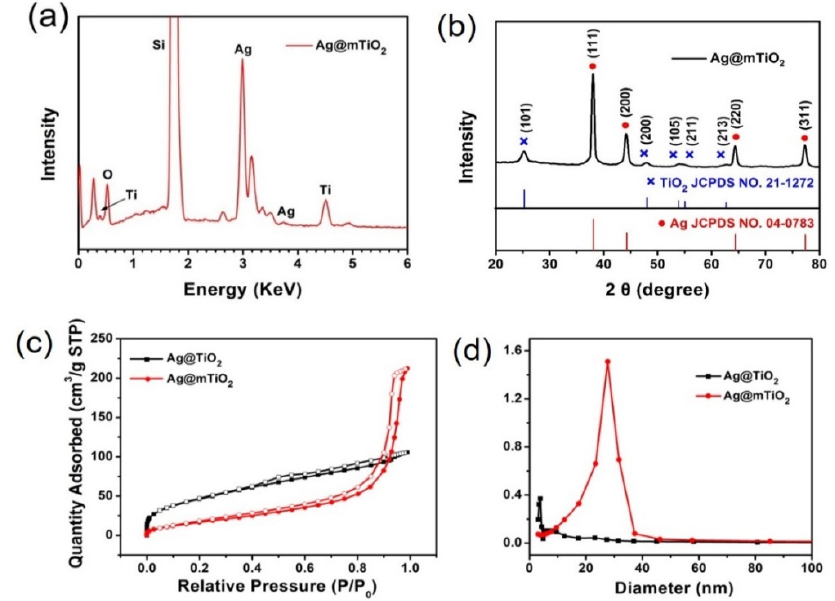
Figure 2. ( a ) EDX spectrum and ( b ) XRD pattern of Ag@mTiO 2 nanoparticles. ( c ) Nitrogen